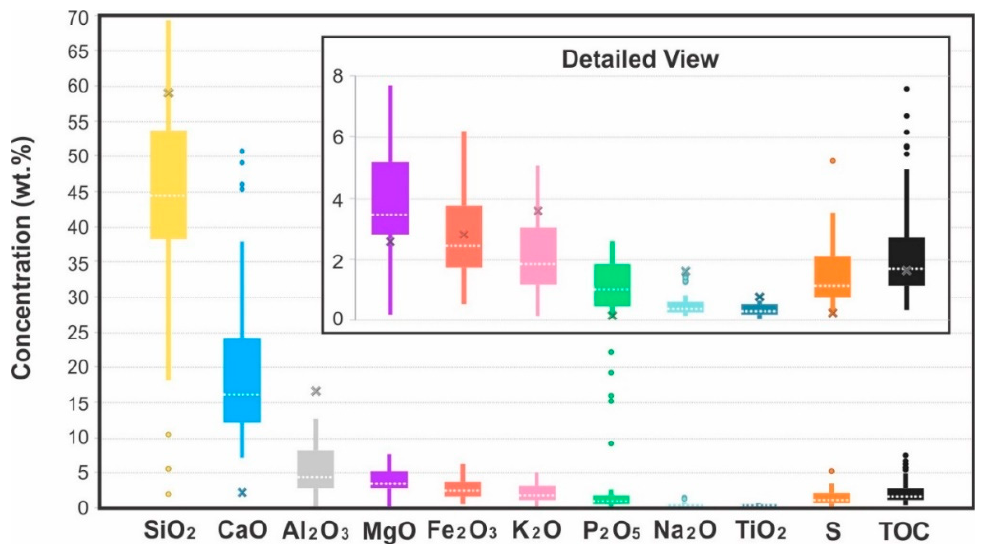
Figure 12. Box plot of all the major elements and TOC from Rock-Eval pyrolysis for all samples analyzed. The box represents the range between the upper and lower quartiles, the whiskers represent the lower and upper limit of adjacent values, and outliers are represented by dots. The dotted white line represents the median. Crosses represent the global average concentration of elements [43] and TOC [44] in shales.